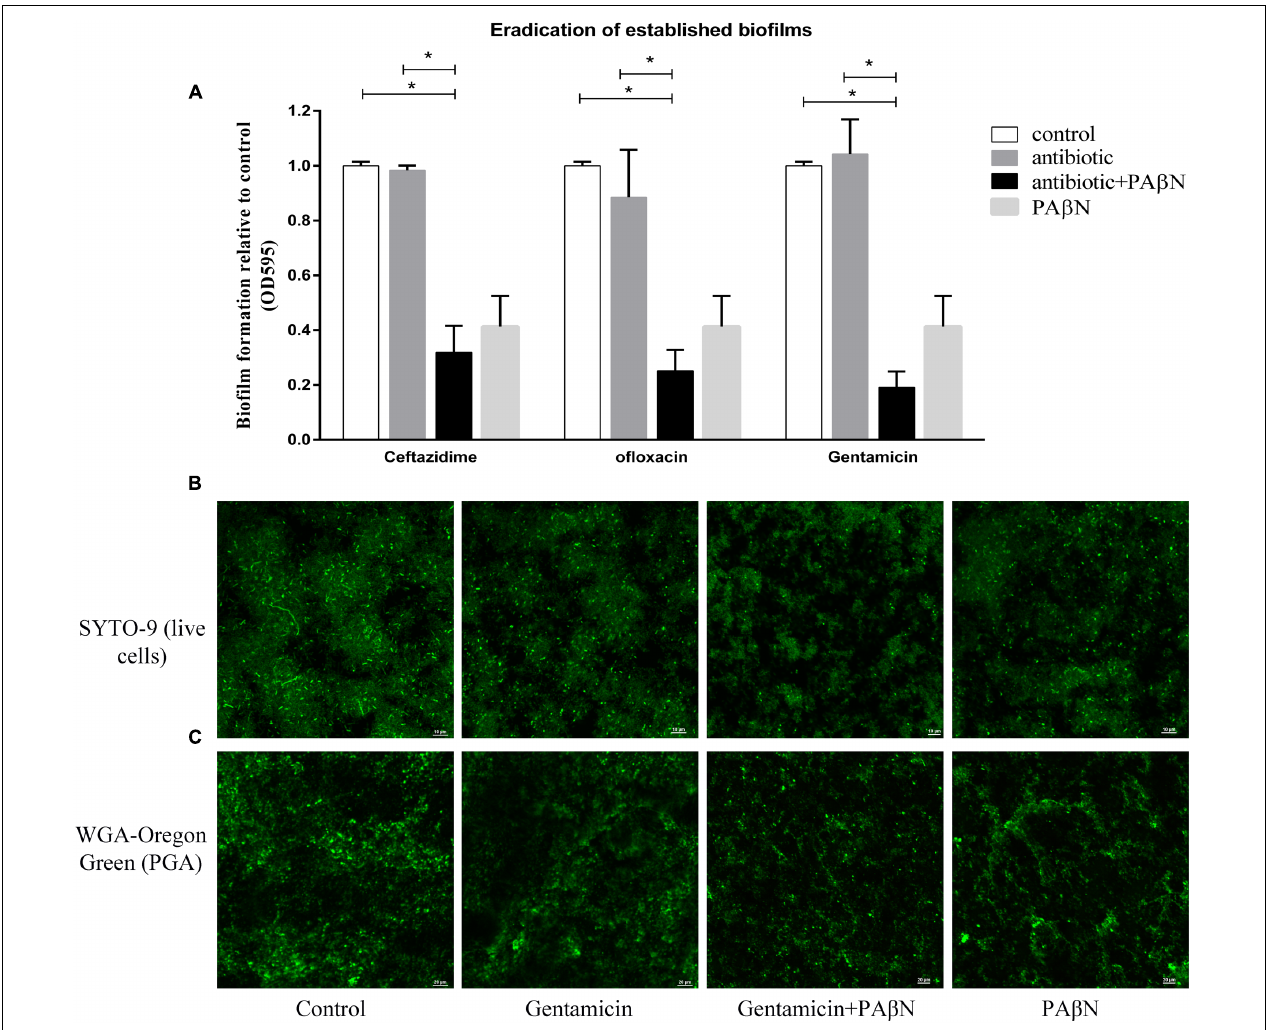
FIGURE 6 | Eradication of established biofilms of A. pleuropneumoniae by antibiotics with or without PA β N. (A) Biofilm eradication was significantly increased by sub-bactericidal concentrations of antibiotics (1 µ g/ml of ceftazidime, 1 µ g/ml of ofloxacin, or 10 µ g/ml of gentamicin) in combination with PA β N (160 µ g/ml). Data indicate mean of three independent experiments performed in duplicates, error bars indicate SD, ∗ P < 0.05 when compared to the untreated control using two-way ANOVA. CLSM images of persistent biofilm cells with intact cell membranes were colored green by SYTO 9 (B) and the biofilm matrix was characterized by staining PGA with WGA-Oregon green (C) . Overnight grown biofilms of A. pleuropneumoniae SC1516 were significantly eradicated by gentamicin combining PA β N, showing sparse bacteria colonies and scattered WGA fluorescent